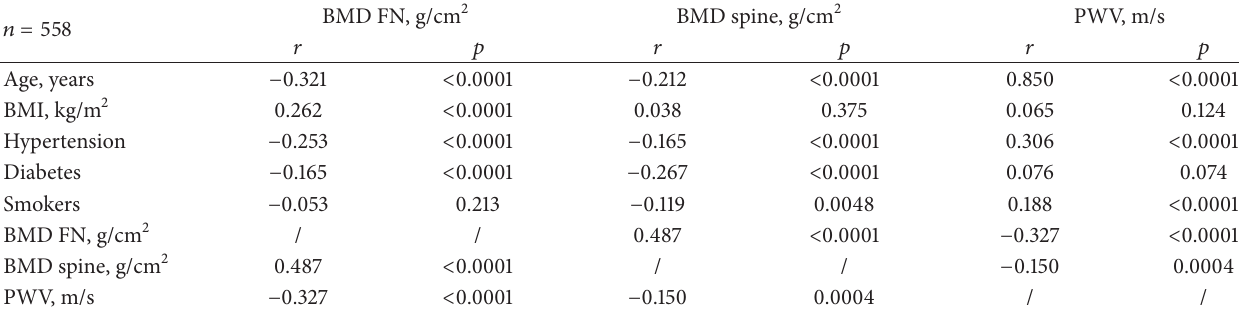
Table 2: Bivariate Pearson’s correlation analysis of demographic characteristic with BMD and PWV.